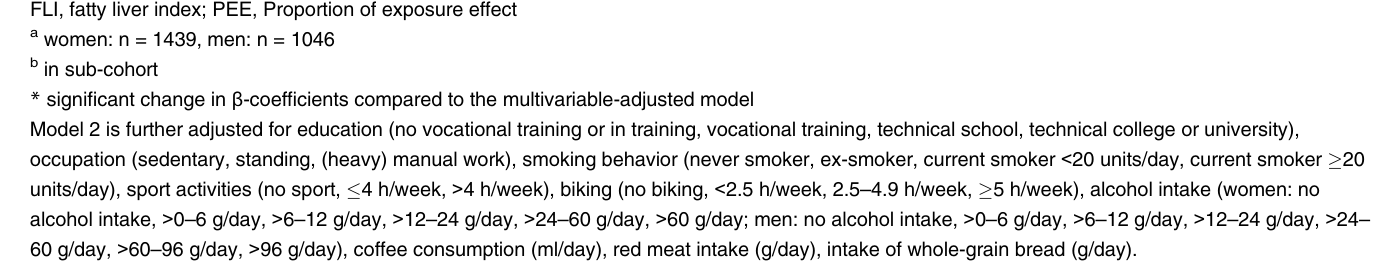
In the age-stratified model, men in the third category ( (cid:1) 60) had a HR of 11.4 (95% CI 6.70 – 19.3) (see Table 2). Adjustment for lifestyle and other socioeconomic factors showed no sub- stantial change: HR 10.9 (95% CI 6.22 – 19.2). Further adjustment for BMI or waist circumfer- ence at baseline attenuated the association between the FLI and risk of type 2 diabetes in men, (95% CI) = 53.8% (43.9% – and no differences between both measures were observed [PEE BMI (95% CI) = 54.8% (44.2% – 68.8%)]. Adjustment for GGT showed no attenu- 65.8%) vs. PEE waist ating effect in men. The inclusion of triglycerides resulted in a PEE (95% CI) = 6.23 (2.03% – TG 11.8%) in the highest category.